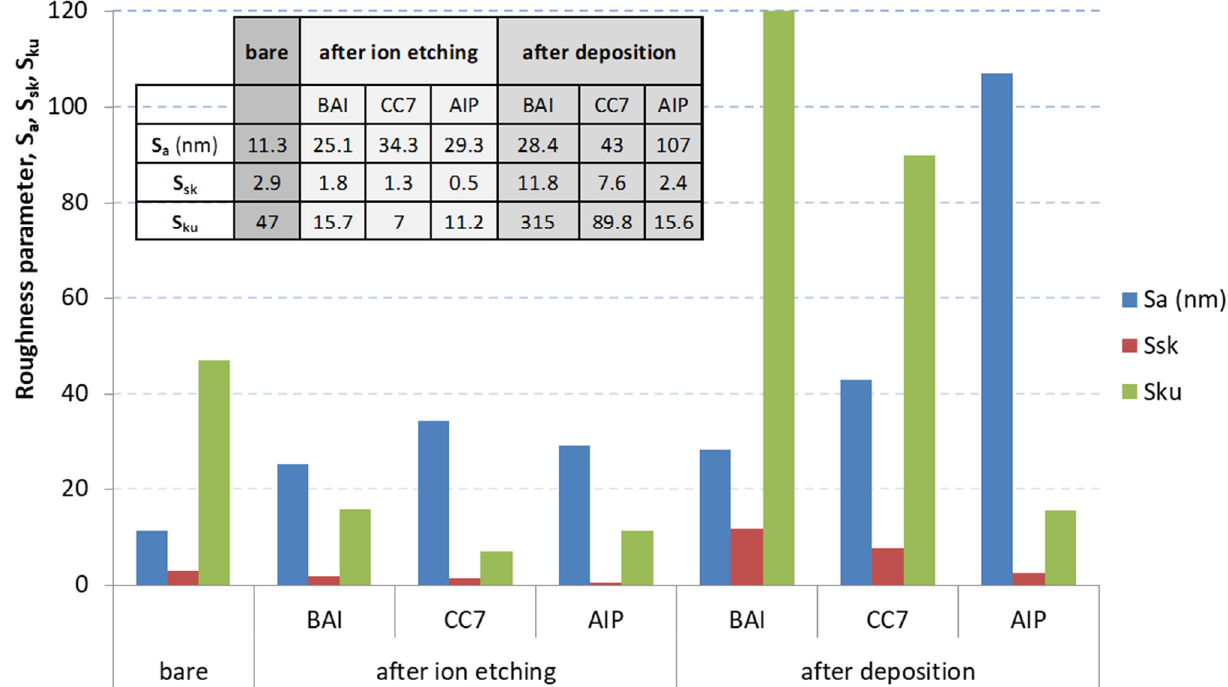
Figure 5. Roughness parameters (S a , S sk and S ku ) of D2 substrate, after polishing, after ion etching, and after deposition of TiN coatings in BAI, CC7 and AIP systems.